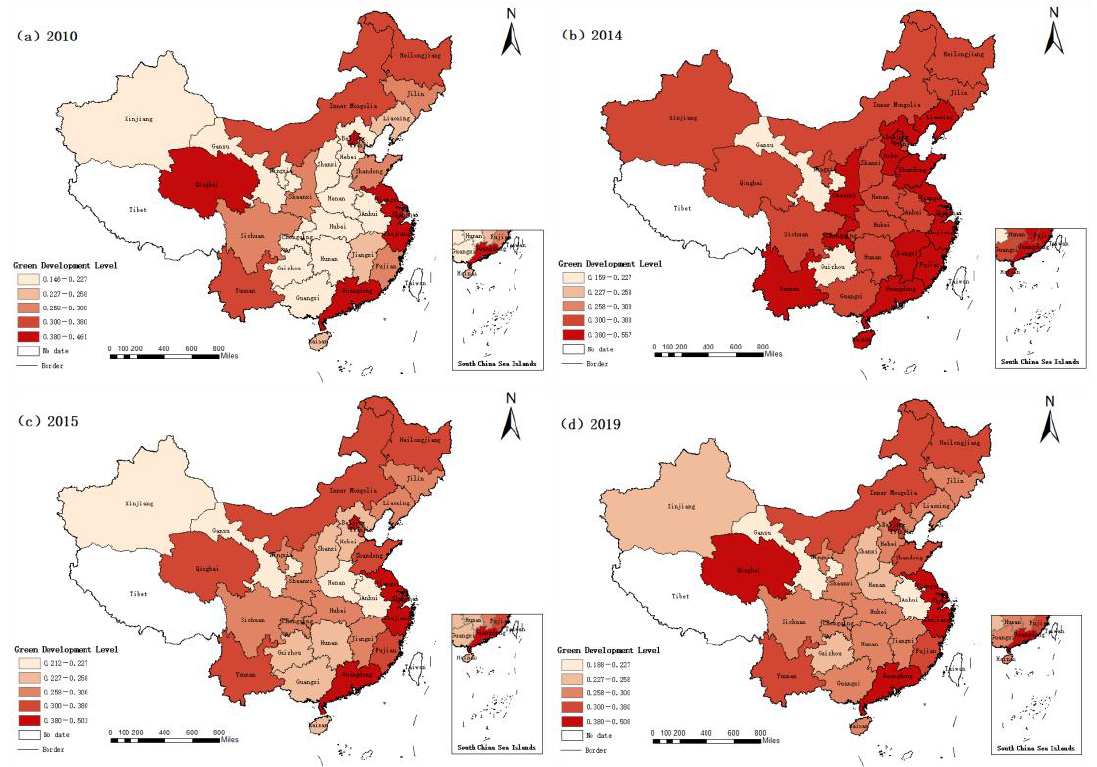
Figure 2. Spatial and temporal patterns of China’s green development in 2010, 2014, 2015 and 2019.